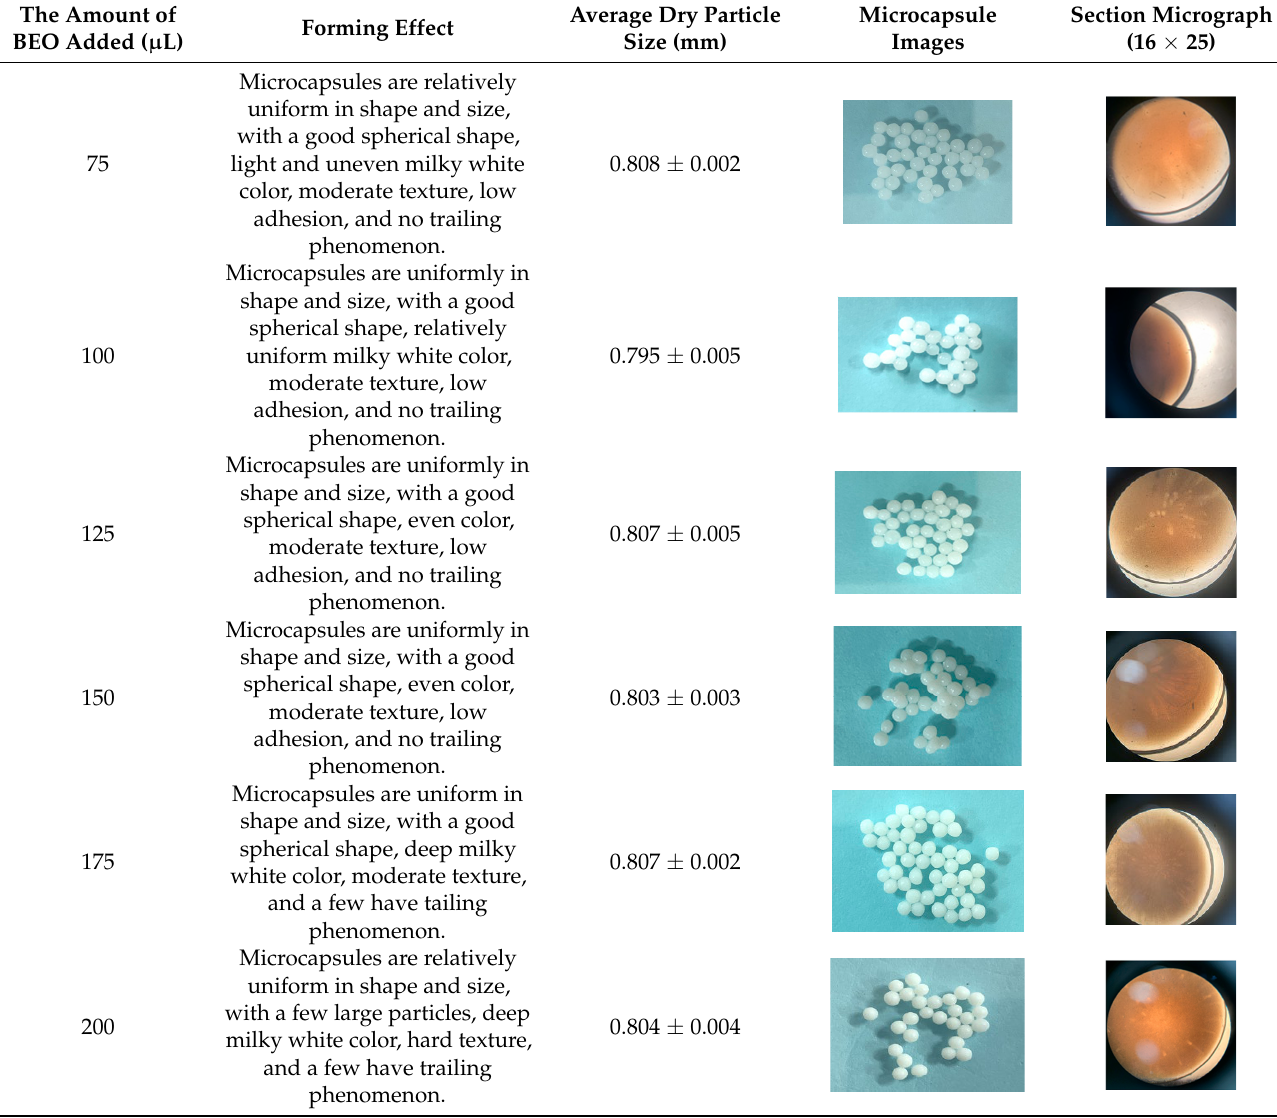
Table 3. Effect of CaCl 2 concentration on microcapsule formation.